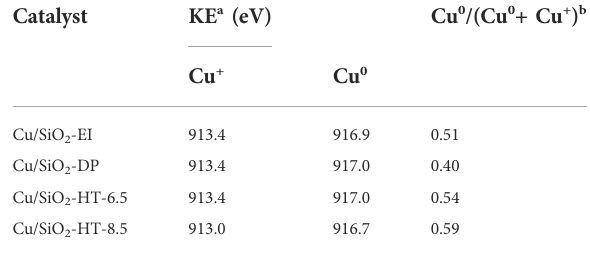
Table 3. HMF was completely converted in all cases,